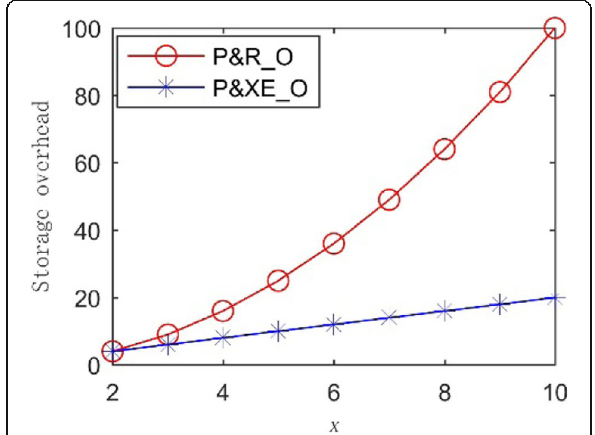
Fig. 18 Comparison of user storage overhead under the same data survivability